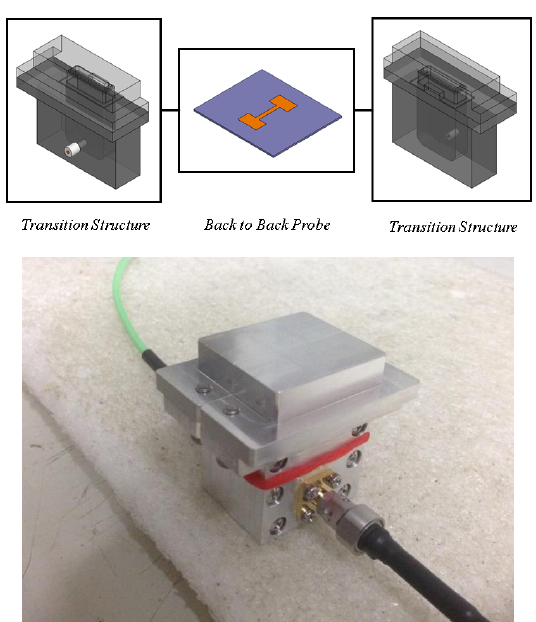
Figure 10: Photo of the back-to-back waveguide-to- microstrip